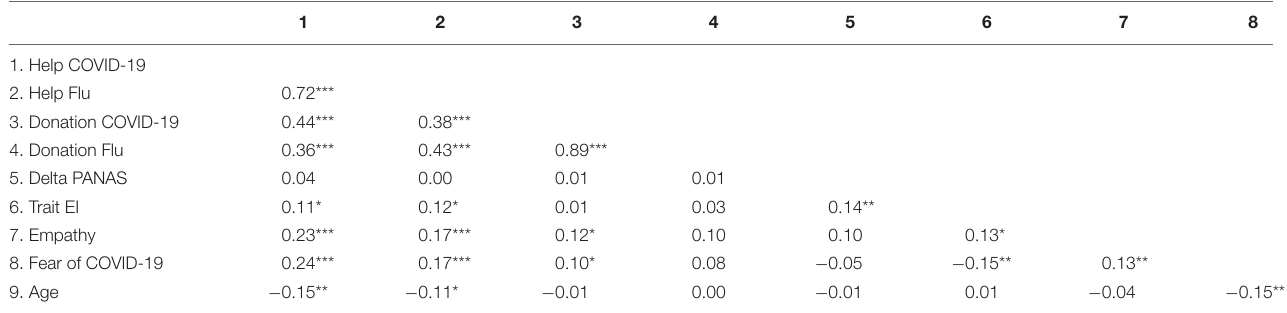
TABLE 2 | Correlation matrix between main variables.